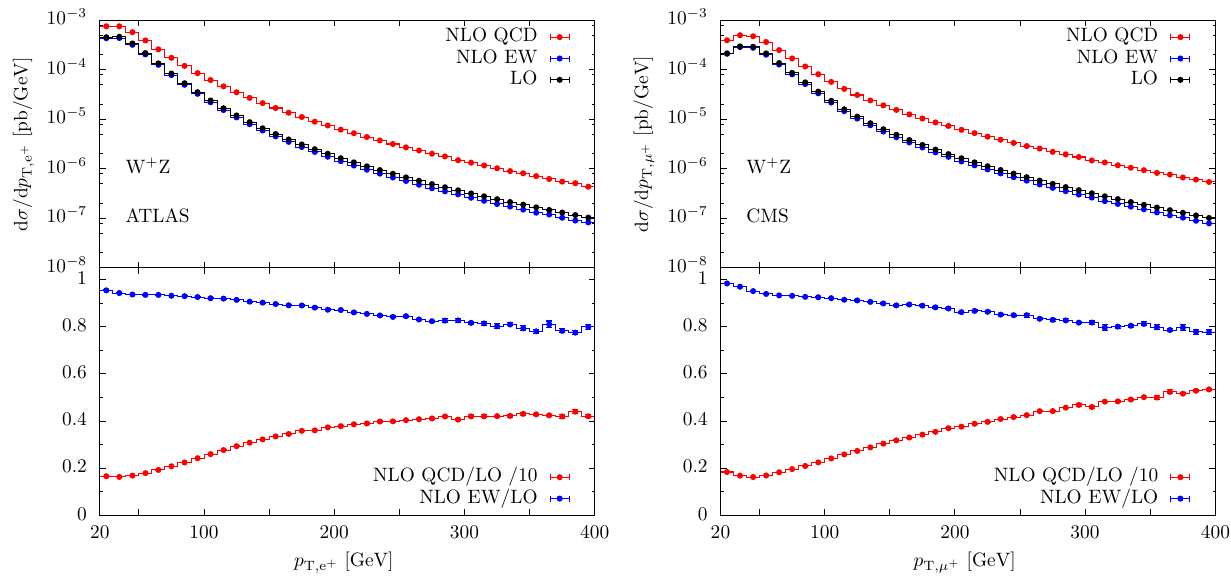
Fig. 10 Upper panels: differential distributions in the transverse In order to improve the plot readability the NLO QCD predictions have been divided by a factor 10 in the ratio NLOQCD / LO. For all curves momentum of the positron ( p T , e + ) and the antimuon ( p T ,μ + ) for the √ s = 13TeV for the ATLAS and CMS the central value of the factorization and renormalization scales is used process pp → e + ν e μ + μ − at and the error bars correspond to the statistical integration uncertainties. event selections of Eqs. (4.7) and (4.8), respectively. The LO results Note that the same PDF set is employed for both the LO and NLO (blacklines)arecomparedtotheonesatNLOQCD(redlines)andNLO predictions EW (blue lines). Lower panels: ratio of the NLO QCD, and NLO EW contributions with respect to the LO (red and blue lines, respectively).